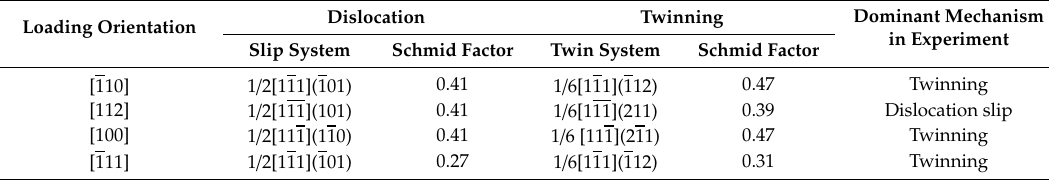
Table 2. The largest Schmid factors on the dislocation slip and deformation twinning systems for the four loading orientations tested in body-centered cubic (BCC) W